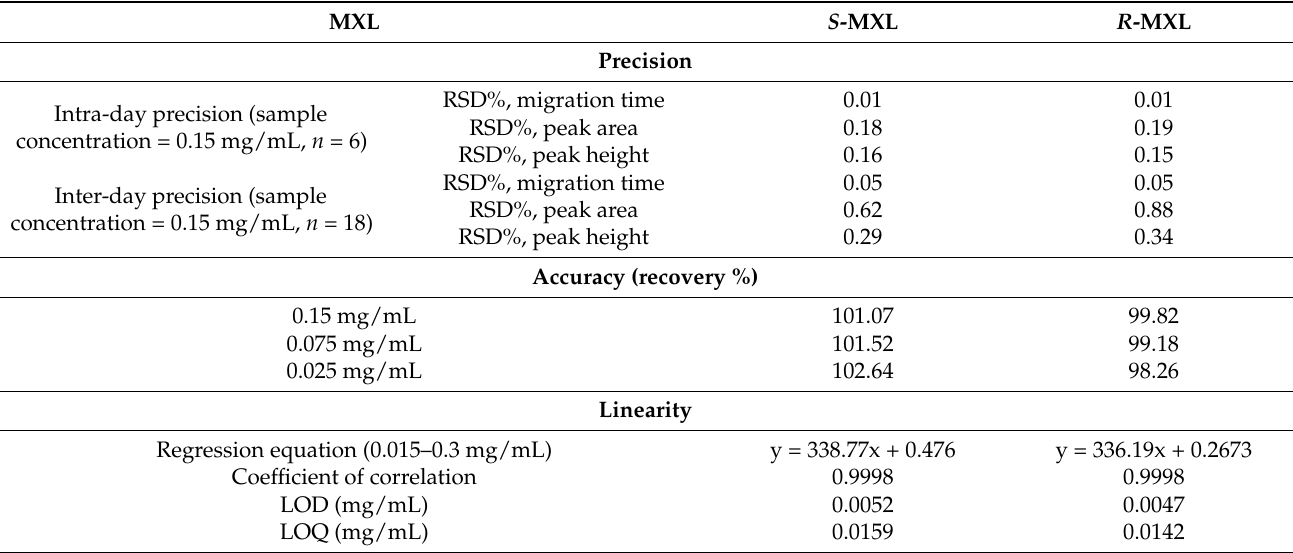
Table 4. Analytical performance of the optimized method.